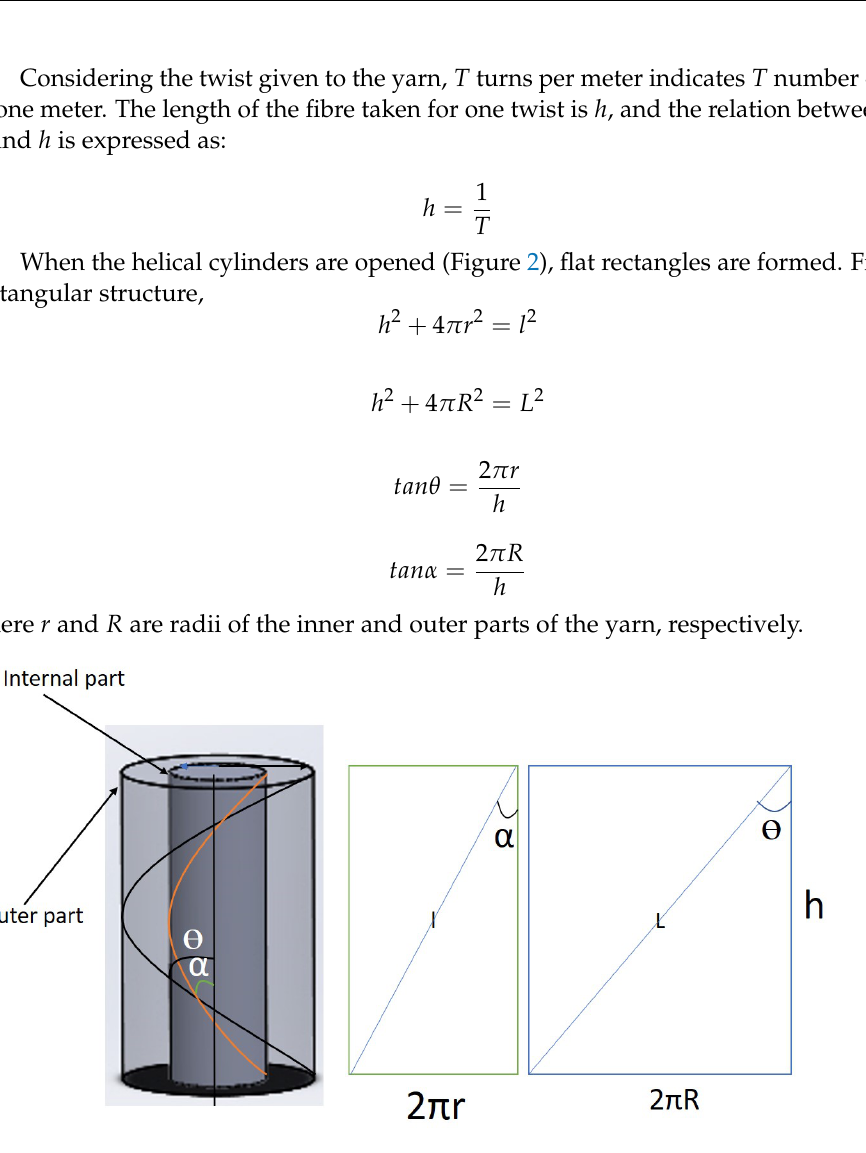
Figure 2. Helical yarn at its different diameters.